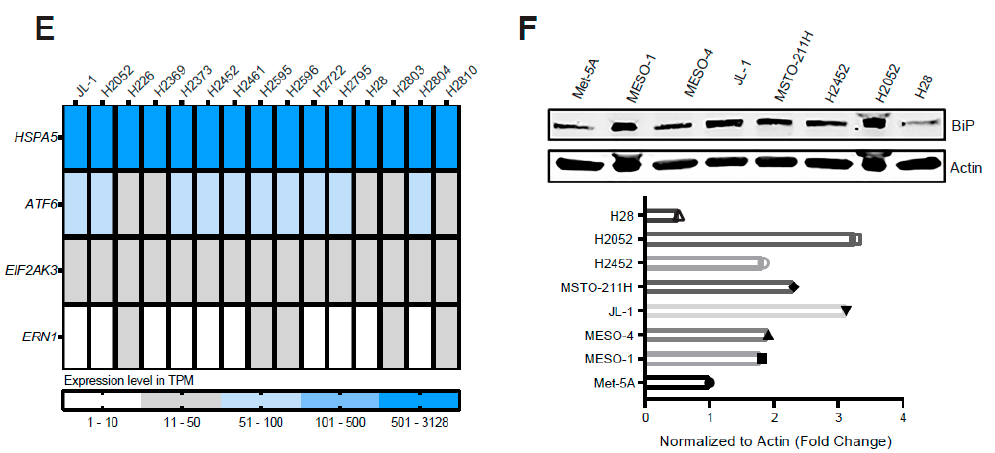
Figure 1. Endoplasmic reticulum (ER) stress / unfolded protein response (UPR) signaling is deregulated in malignant pleural mesothelioma (MPM). ( A ) Gene set enrichment analysis (GSEA) of the dataset (GSE2549) revealed significant enrichment of UPR in MPM tumor samples. ( B ) The UPR gene signature was positively correlated with the proliferative marker PCNA and anti-apoptotic marker SURVIVIN / BIRC5 . Gene expression data of MPM were downloaded from TCGA, with Pearson / Spearman coe ffi cients and p -value determined using R (version 3.4.3). ( C ) Kaplan-Meier analysis of a TCGA cohort of MPM patients ( n = 86). The UPR gene signature was dichotomized based on the optimal cut-o ff value, and patient survival data were extracted for further analysis using R (Version 3.4.3). The p -value was calculated by the log-rank test. ( D ) The volcano plot of transcriptional comparison between the patients’ MPM vs. normal lung tissues (GSE51024). ( E ) Heatmap of key UPR gene expression (TPM) in the MPM cell lines. The expression profile was obtained from the European Bioinformatics Institute of European Molecular Biology Laboratory (EMBL-EBI). ( F ) Immunoblots of BiP in normal mesothelial cells (Met-5A) and MPM cell lines. Relative expression of BiP is shown underneath, with signal intensity quantified by ImageJ and normalized to the loading control ( β -actin). The value in the Met-5A was set as